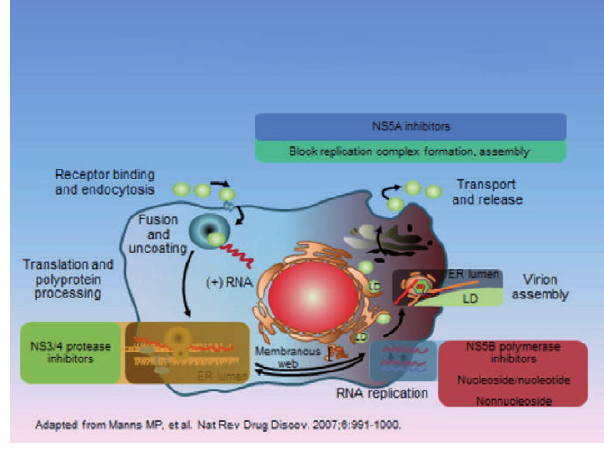
Figure 12. HCV life cycle and DAA target.